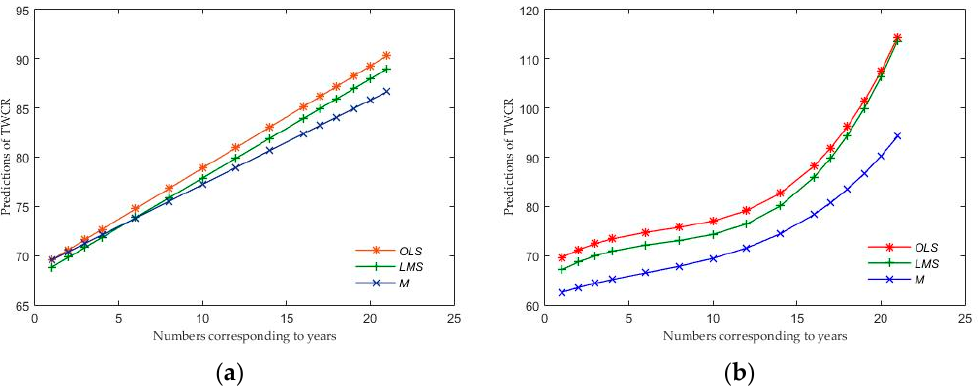
Figure 1. Estimated growth curve models (GCMs) to TWCRs of Turkey’s watersheds and short-term predictions; ( a ) first-order GCMs; ( b ) third-order GCMs.